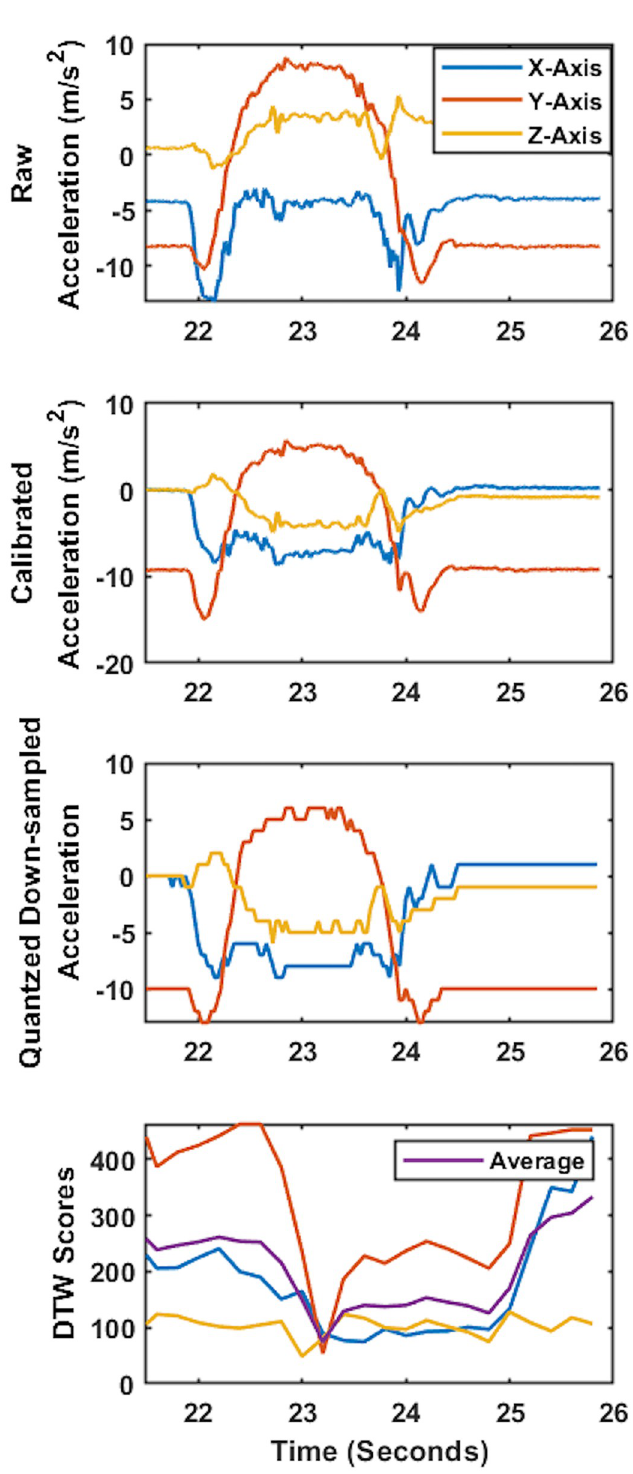
Fig 2. Sample 3D acceleration time-series and associated DTW scores. a) Raw 3D acceleration time-series during a face touch, b) acceleration time-series after vertical alignment, c) acceleration time-series after down-sampling and quantization, and d) the DTW scores calculated comparing the pattern of quantized down-sampled acceleration time- series to template time-series (lower score represents more similarity). Considering that the face touch occurred from 22 to 25 sec, it could be observed that in this sample DTW scores decreased while the face touch happened (23 to 24